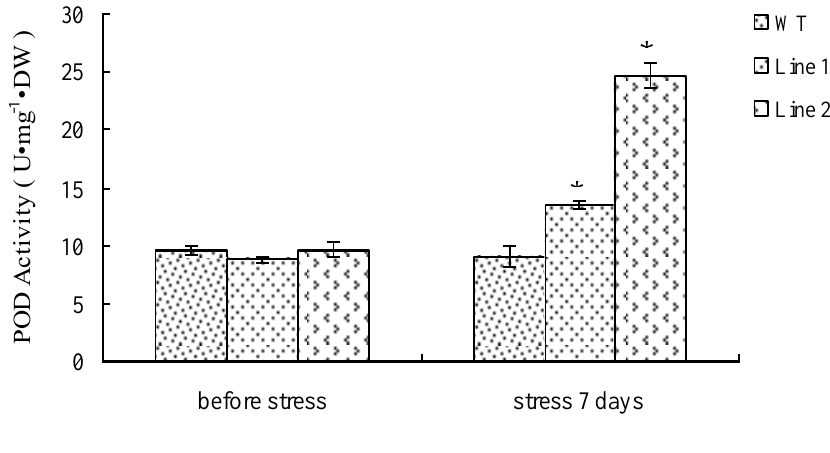
Figure 4. Peroxidase (POD) activity analysis of the TaLEA1 transformed and WT poplar lines. POD activity was determined before stress and after 100 μM CdCl Values are expressed as means ( n = 9 plants); error bars denote SD. * Significant ( t test, P < 0.05) difference compared with WT plants.